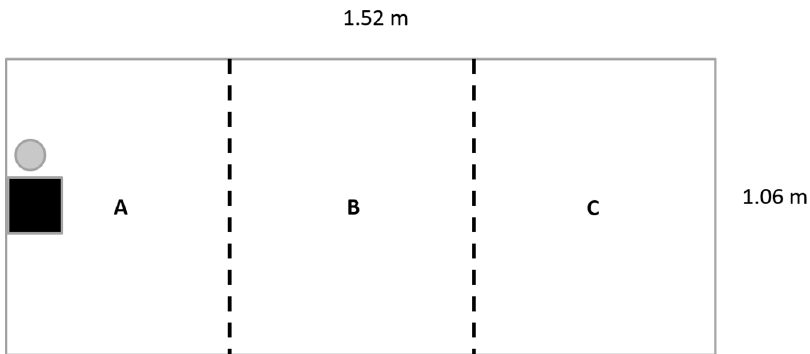
Figure 3. Layout of experimental tanks with scoring grid. Dashed lines represent the grid sections used to determine fish distributions. The black square represents the strobe-light stimulus. The grey circle represents the submerged GoPro camera. Table 1. Rules and examples for cohesion scoring based on number and formation of fishes in the tank.